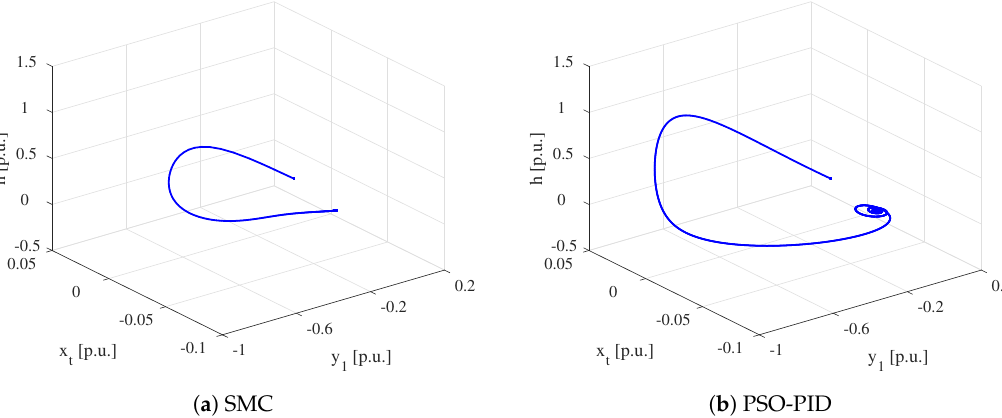
Figure 4. The ternary phase diagrams of y 1 - x t - h regulated by ( a ) SMC and ( b ) PSO-PID under target speed tracking.